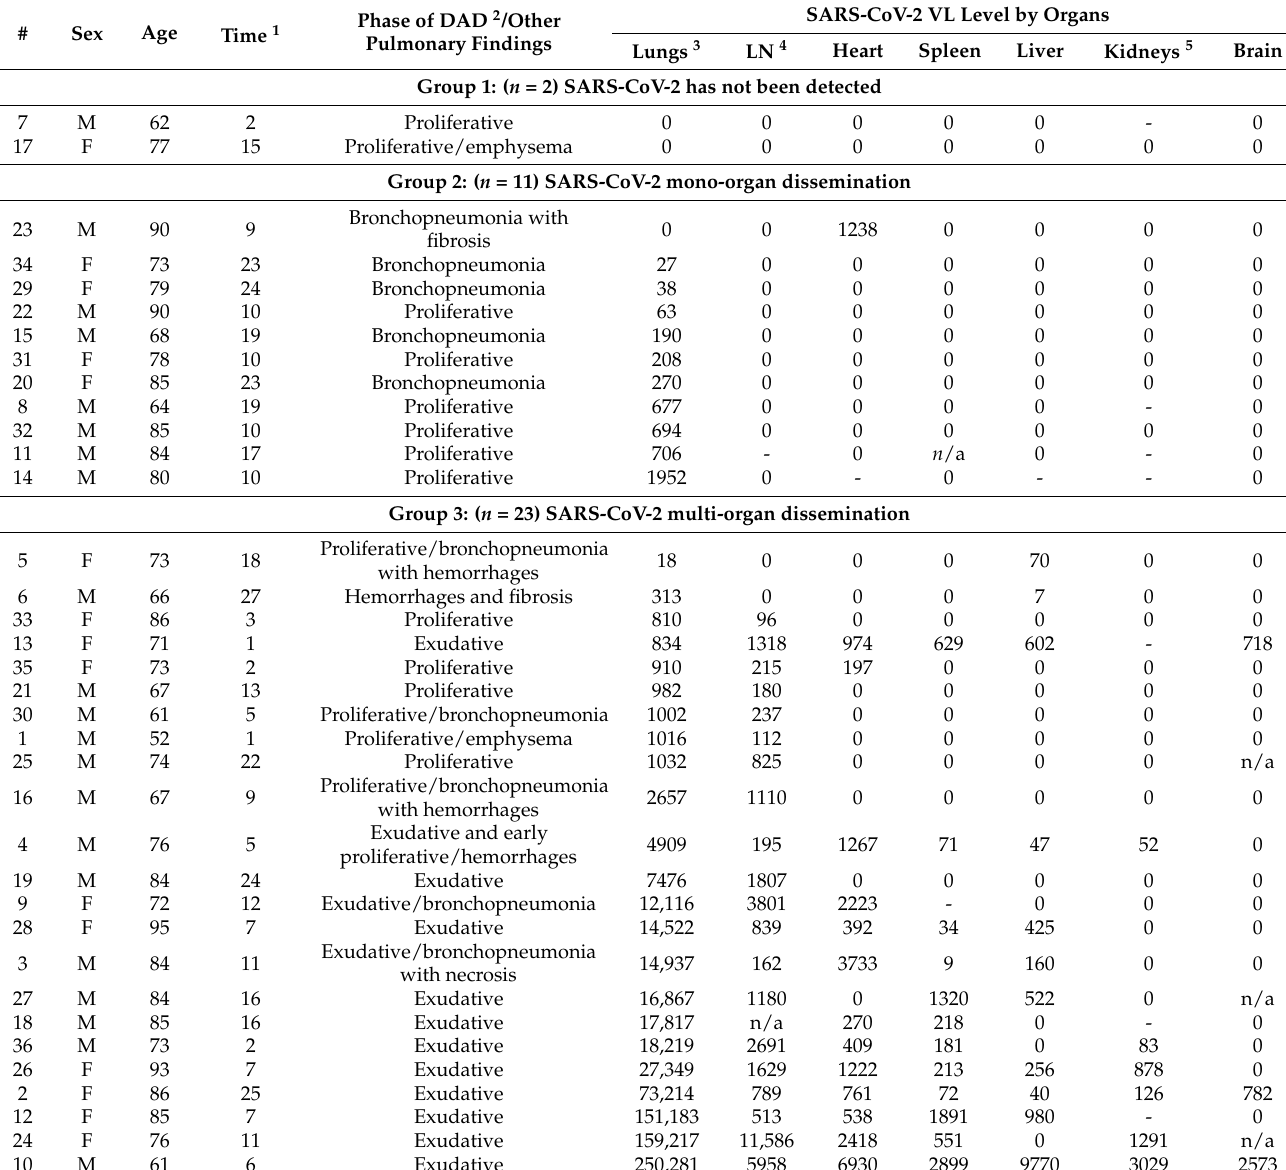
Table 1. General characteristics of patients and SARS-CoV-2 VL level by